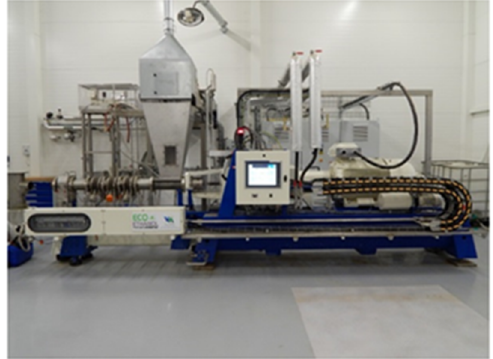
Figure 1. Extruder Clextral Evolum EV 53 for polyphenol